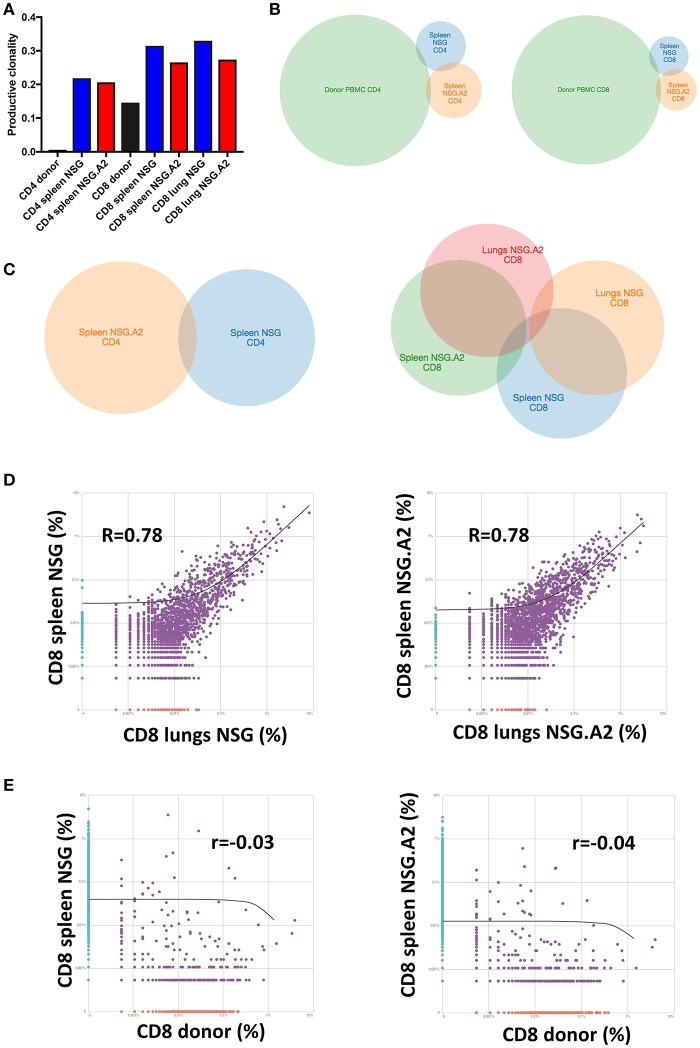
T-cell repertoire of CD4+ and CD8+ T cells in NSG and NSG-HLA-A2/HHD mice. NSG and NSG-HLA-A2/HHD (NSG.A2 in figure) mice were transplanted with HLA-A2− PBMCs and were sacrificed at day 14 to perform TCRβ sequencing on T cells sorted and pooled (10 mice pooled/condition) from their spleen and lungs. (A) Productive clonality of CD4+ and CD8+ T cells sorted from donor PBMCs (before infusion to mice), spleen and lungs of NSG and NSG-HLA-A2/HHD mice. (B,C) Venn diagram comparing the identity of clonotypes between indicated samples (D,E) Correlations of clonotypes productive frequency between indicated samples.